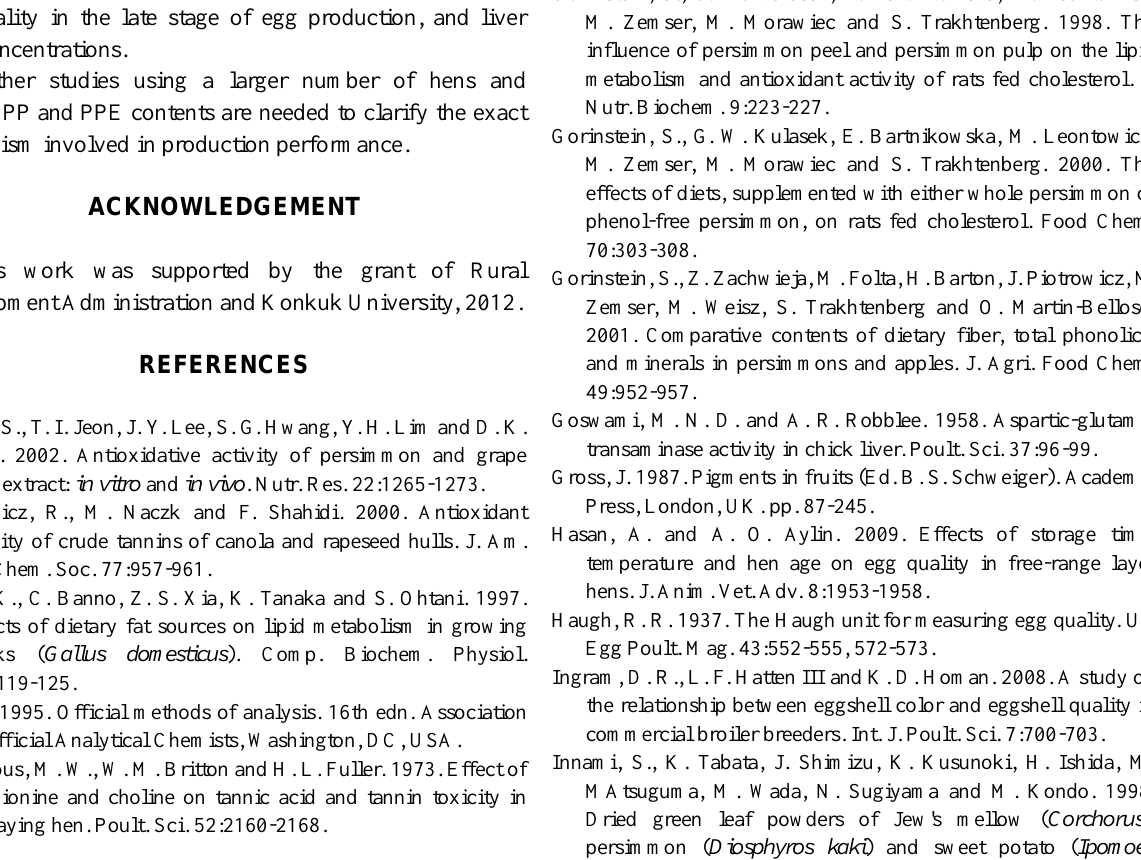
Table 6. Effects of persimmon peel (PP) and persimmon peel ethanol extract (PPE) on lipid fractions of liver in laying hens 1 Items